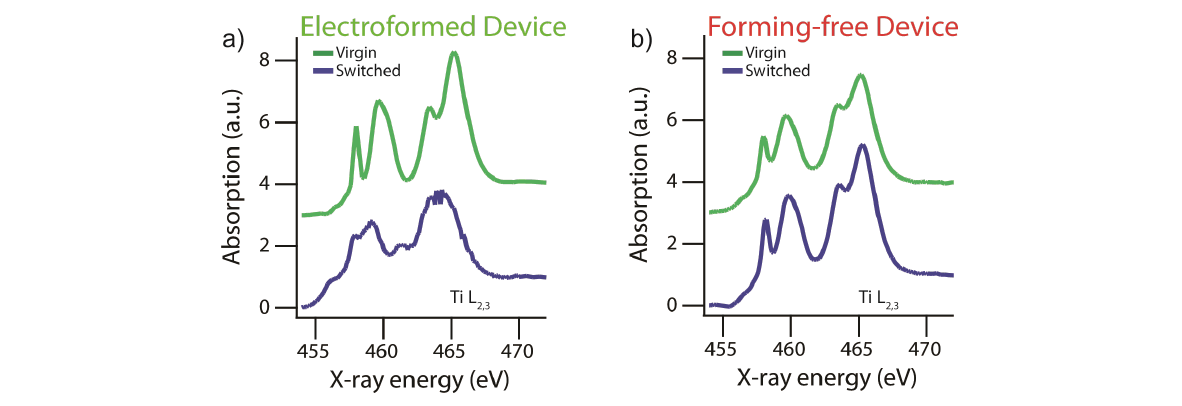
Figure 3: X-ray absorption spectroscopy within the junction region of an electroformed and forming-free device. The Ti L 3 absorption edge is shown, which is sensitive to chemical composition and structure state. (a) The “Virgin” NEXAFS spectrum (green curve) was derived from a neighboring, simultaneously grown device which was not electrically biased, while the “switched” spectrum (blue curve) came from within the materially altered nanoscale region in the electroformed device of Figure 2 with a size of roughly 200 nm × 200 nm. (b) Both “Virgin” and “switched” spectra (green and blue curves, respectively) were derived from the junction region in the forming-free device of Figure 2, before and after the application of electrical bias, respectively.